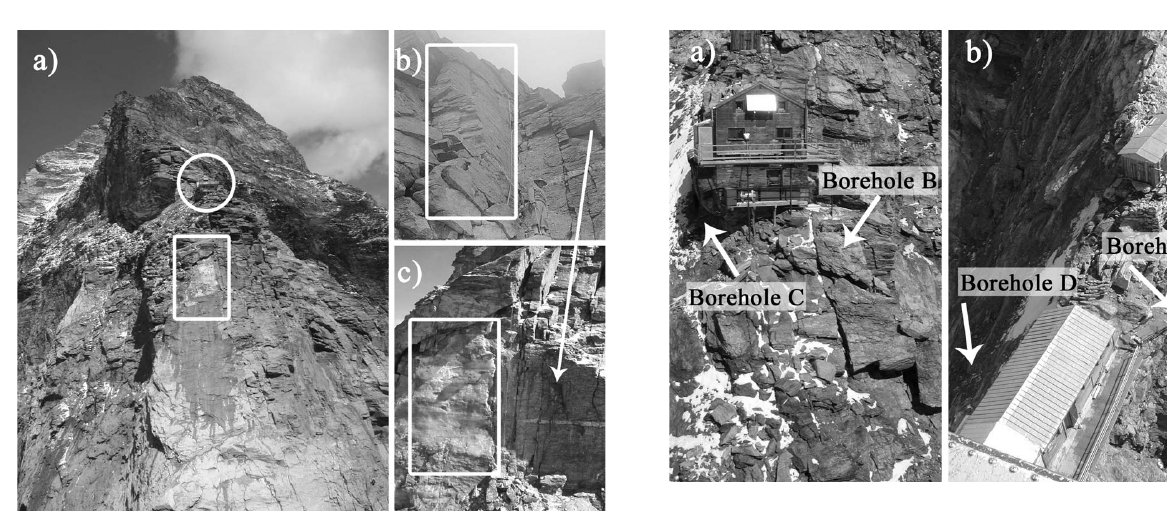
Fig. 4. Position of the boreholes with respect to the Carrel hut (im- ages courtesy of Valle d’Aosta Region,